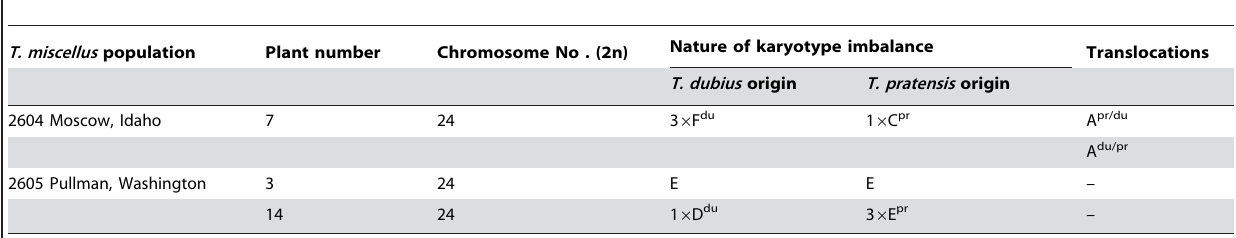
Table 2. Karyotype organisation of individuals of T. miscellus from two populations (localities of each population are indicated in column